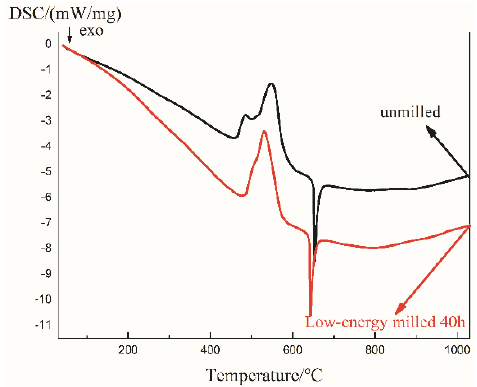
Figure 4. DSC curve of TiH 2 -7Al-0.2B un-milled and low-energy ball milled powders.